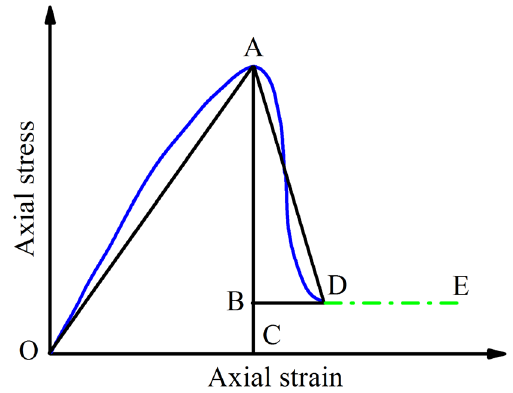
Fig. 12 Brittleness index of different bedding shales before and after LN 2